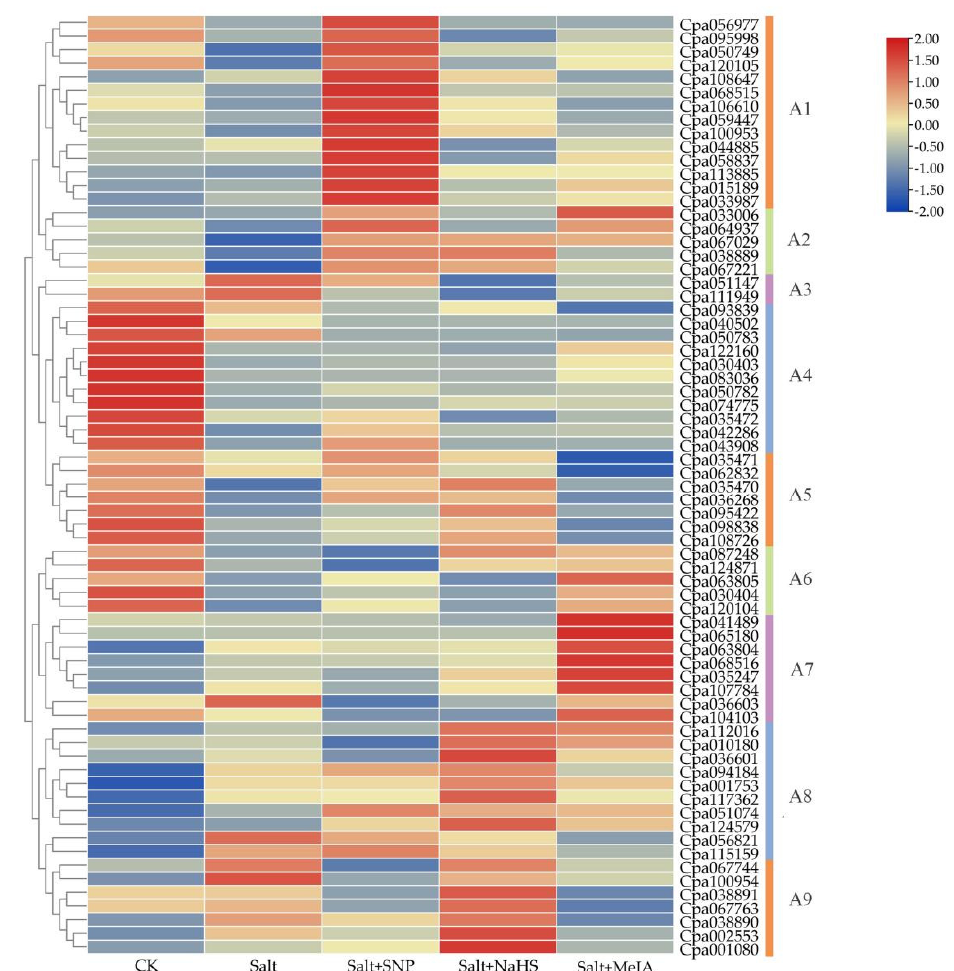
Figure 5. Clustering expression analysis of 69 CpaMYB genes in different salt stress treatments based on the pot experiments. The CK (control), Salt (0.4% NaCl), Salt+SNP (0.4% NaCl with 0.25 mM SNP), Salt + NaHS (0.4% NaCl with 0.5 mM NaHS), and Salt + MeJA (0.4% NaCl with 0.2 mM MeJA) represent the five different treatments. The transcript abundance level was normalized and hierarchically clustered by using the log 2 (FPKM + 1) comparison among genes of different treatments. The expression value is presented on the color scale, with red representing high expression and blue representing low expression. A1–A9 represent different clusters. In order to distinguish A1–A8 clusters more intuitively, lines of different colors were used on the right.